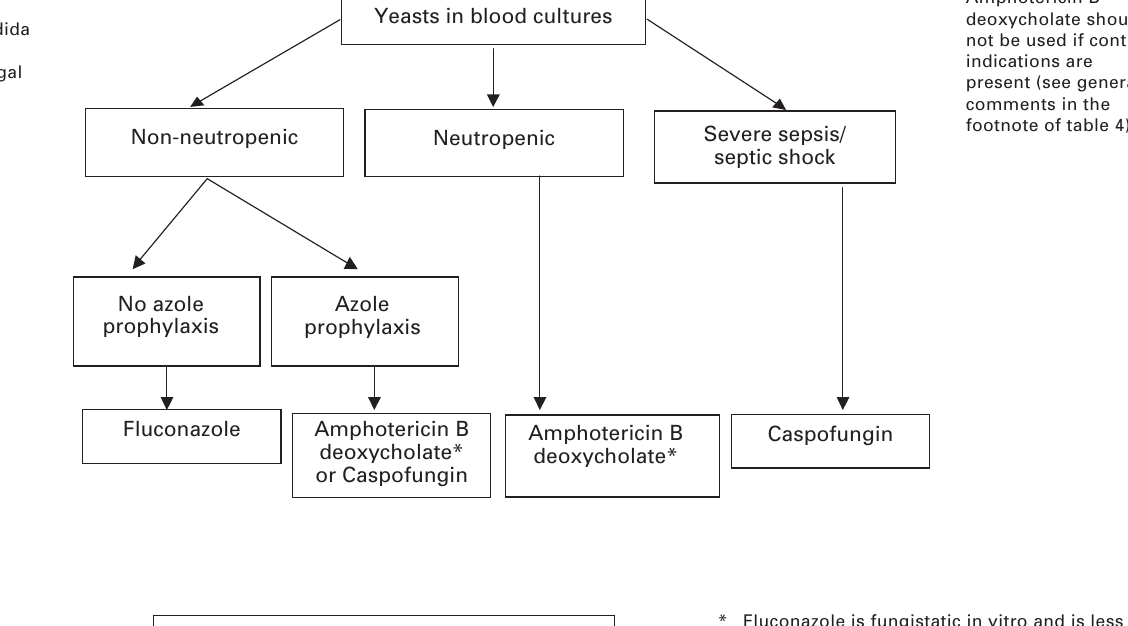
Invasive candidiasis: treatment options once species identity and susceptibility are known. For dosages and alternative drugs see table